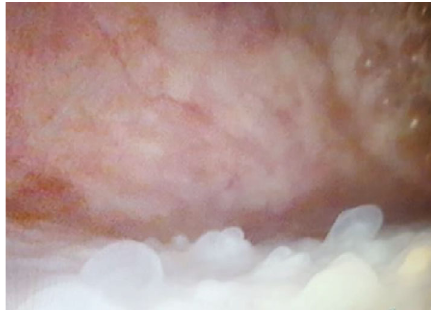
Figure 2: Cystoscopic appearance of NA 5 years after the second transplantation; multiple friable red and white polypoid lesions in the bladder trigone and the roof. Histopathology showed no malignant